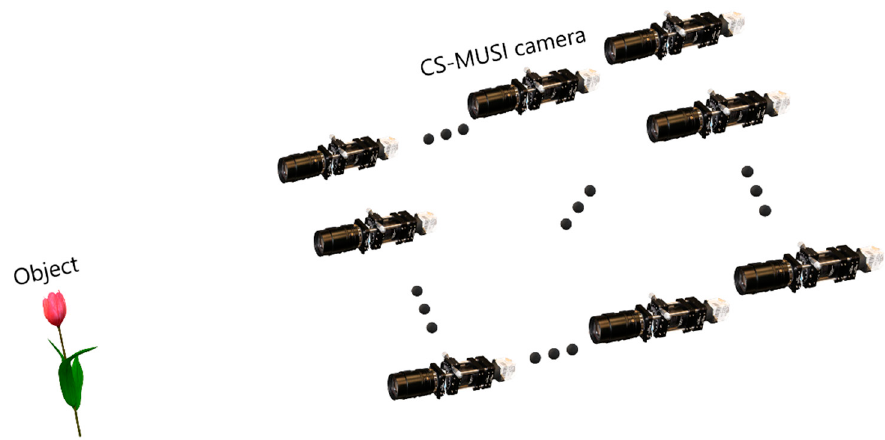
Figure 12. Compressive HS synthetic aperture InIm acquisition setup.